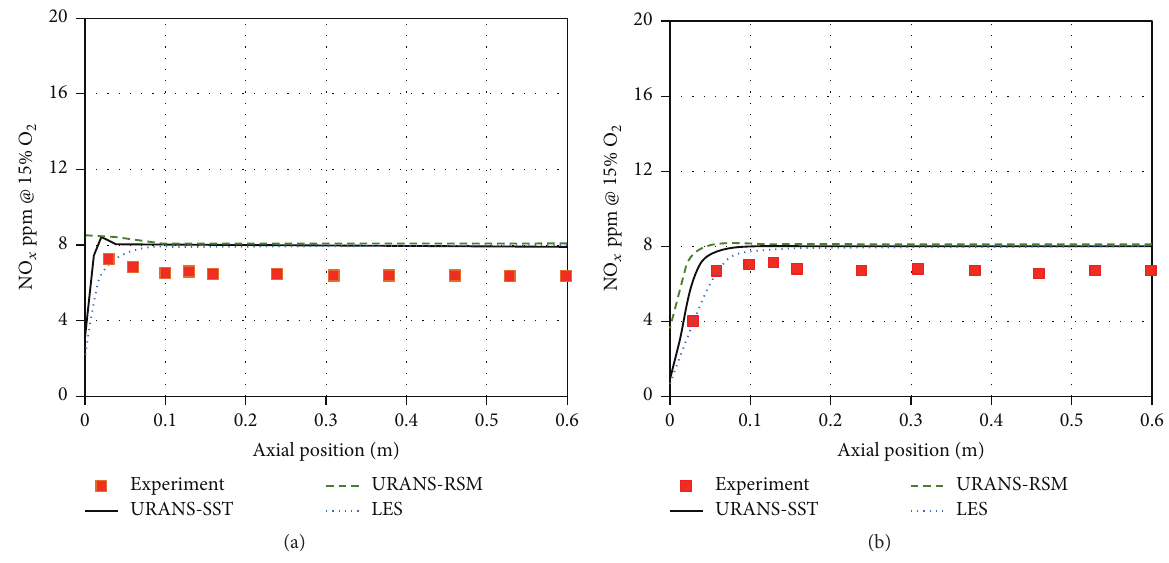
Figure 12: Predicted and measured profiles of time-averaged NO mass fraction along (a) combustor axis and (b) evaluation line for NG- FGR20 flame.